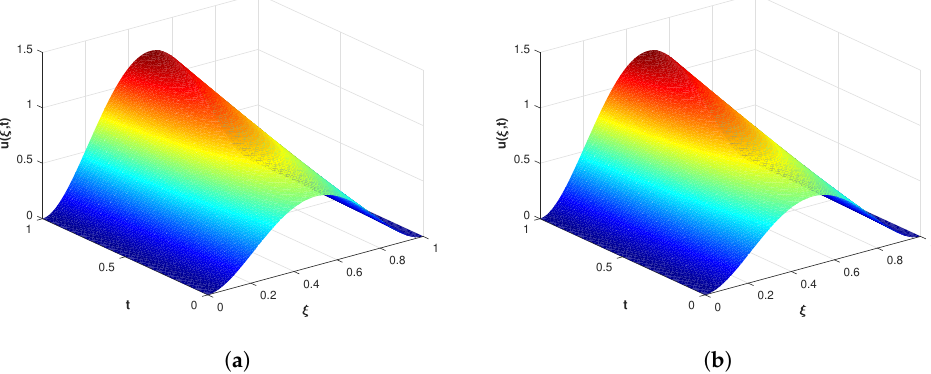
Figure 7. ( a ) Approximate solution of Problem 2 with α = 0.5. ( b ) Analytic solution of Problem 2 with α = 0.5. It is observed that the numerical solution agrees well with the exact